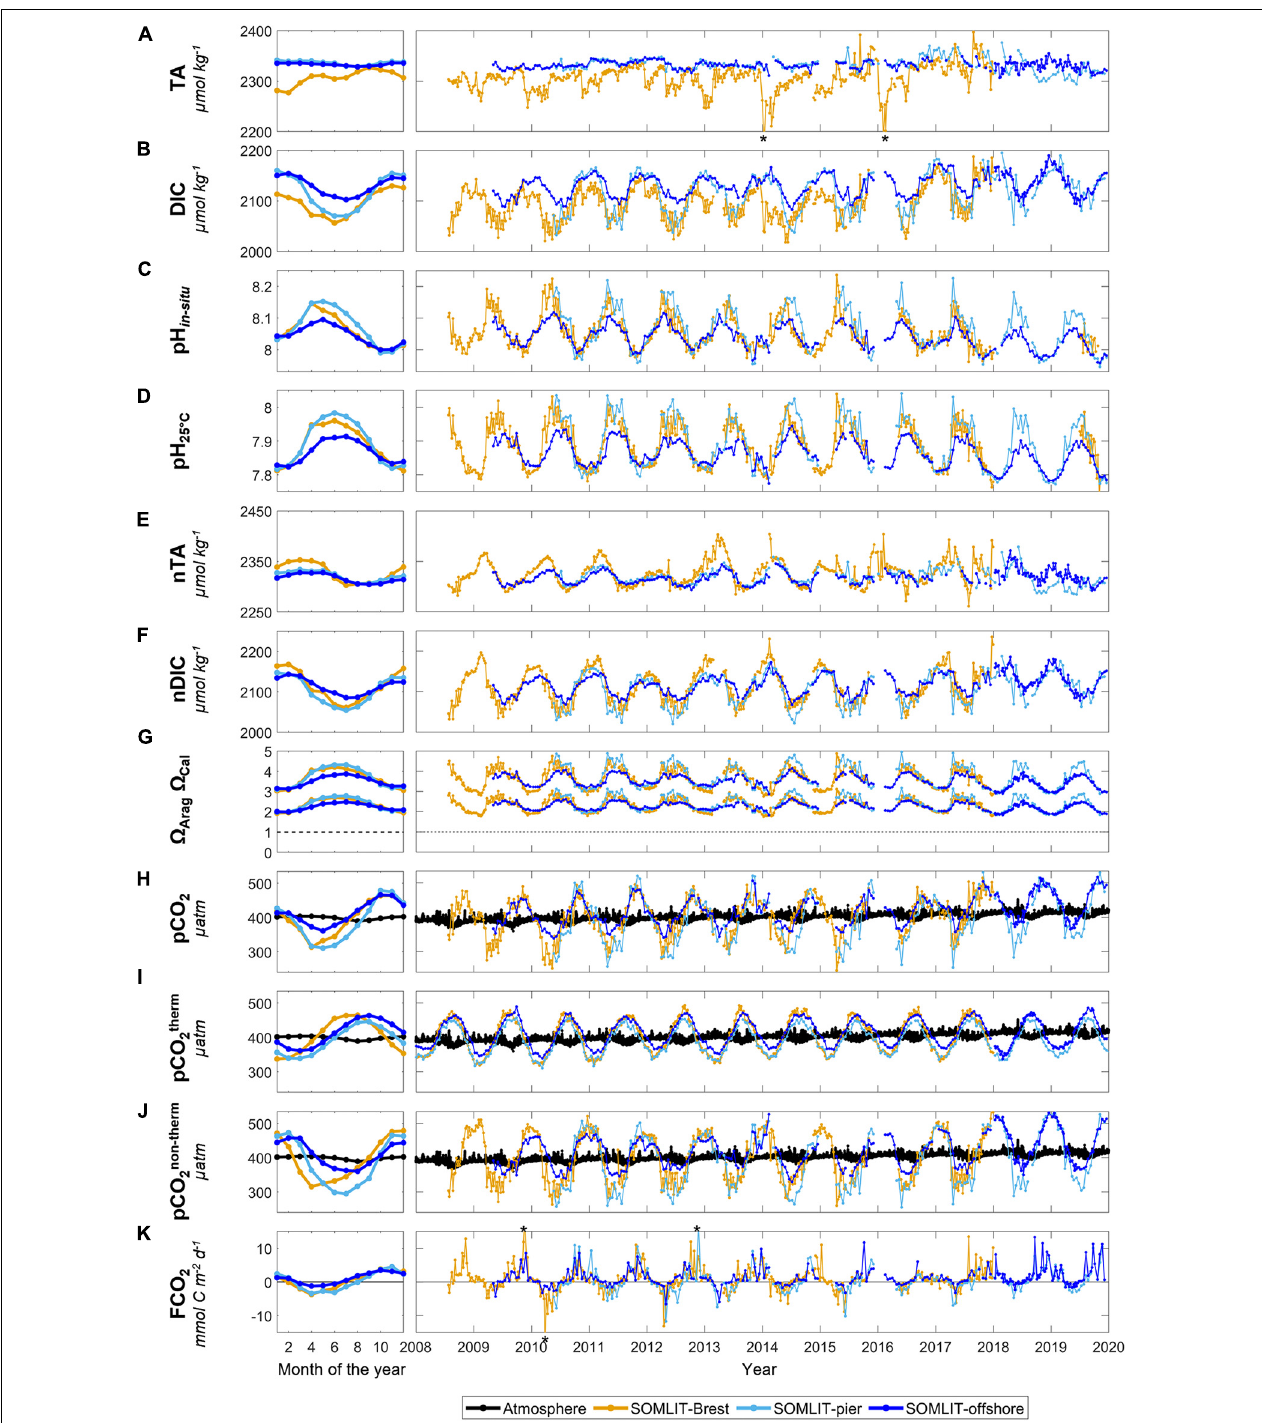
FIGURE 4 | Monthly mean climatology for (A) total alkalinity (TA, µ mol kg − 1 ), (B) dissolved inorganic carbon (DIC, µ mol kg − 1 ), (C) pH in situ , (D) pH 25 ◦ C , (E) SSS normalized TA (nTA, µ mol kg − 1 ), (F) SSS normalized DIC (nDIC, µ mol kg − 1 ), (G) (cid:127) Arag and (cid:127) Cal , (H) pCO 2 ( µ atm), (I) pCO 2 therm ( µ atm), (J) pCO 2 non − therm ( µ atm), and (K) FCO 2 (mmol C m - 2 day − 1 ) at SOMLIT-Brest (orange), SOMLIT-pier (light blue), and SOMLIT-offshore (dark blue), from January 2010 to December 2017, and the associated time series of weekly/bimonthly data from January 2008 to January 2020. The black line represents atmospheric pCO 2 ( µ atm). TA values down to 2194 and 2181 µ mol kg − 1 (out of figure range and indicated by black asterisks) were observed in January 2014 and February 2016, respectively. FCO 2 values of 18.9, –20.82, and 17.3 mmol C m - 2 day − 1 were recorded in November 2009, March 2010, and November 2012 (indicated by a black asterisk), respectively. nTA and nDIC computations were based on Friis et al. (2003) and the SSS vs. TA/DIC relationships from Figure 2 .